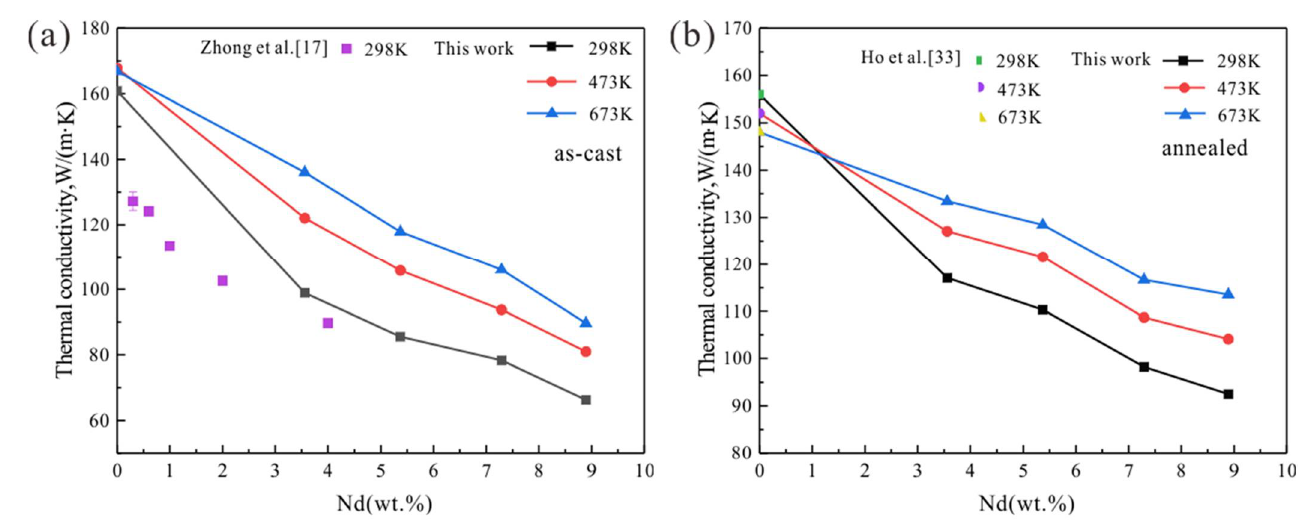
Figure 7. Thermal conductivity of ( a ) as-cast Mg-Nd alloys; ( b ) annealed Mg-Nd alloys.